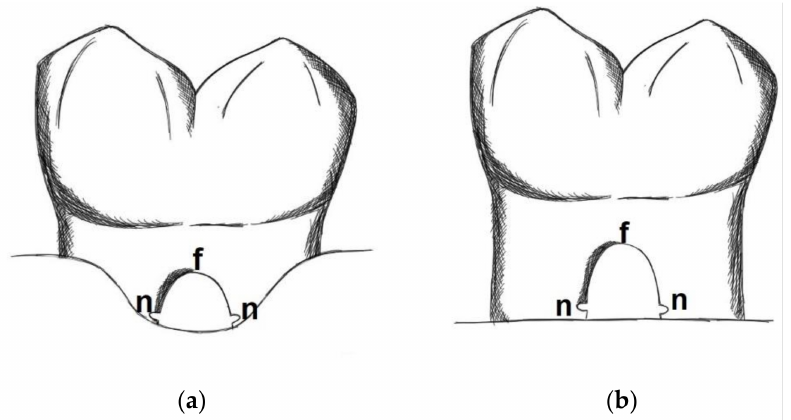
Figure 1. Small keyhole defect ( a ) and horizontal defect type ( b ). After chronification of the defects notches (n) were made with a round bur at the level of the bone crest at the apical end of the furcation